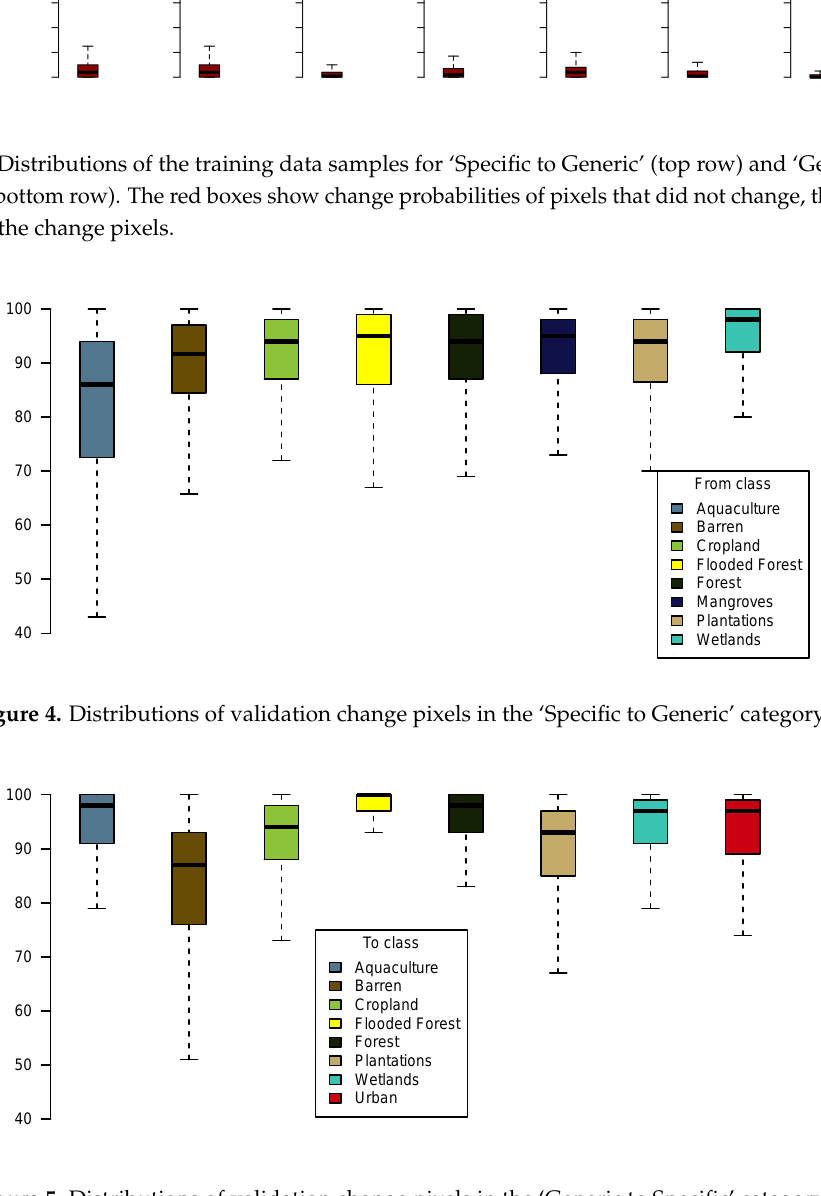
Figure 5. Distributions of validation change pixels in the ‘Generic to Specific’